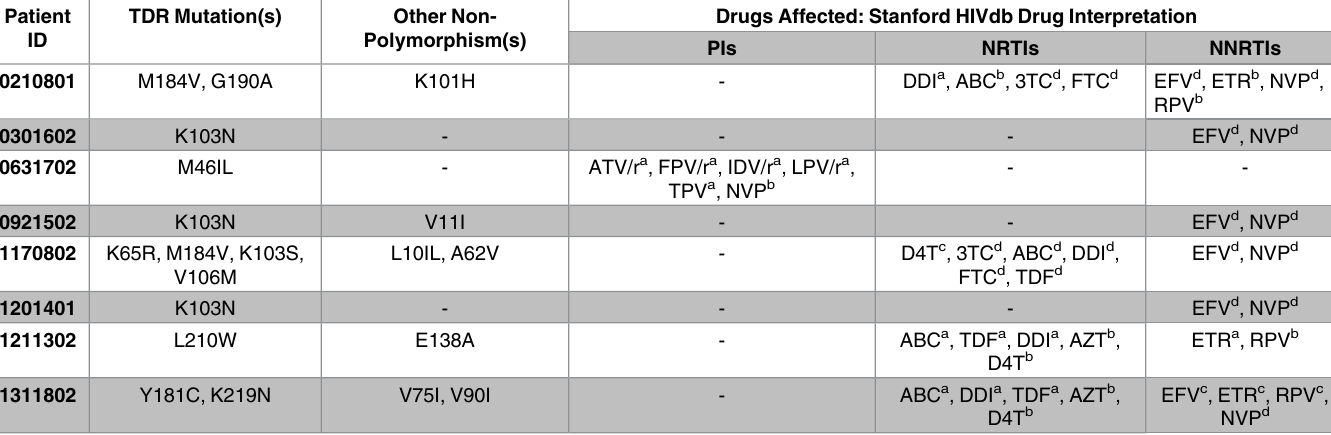
Table 3. ARV drug resistance levels among persons with TDR.